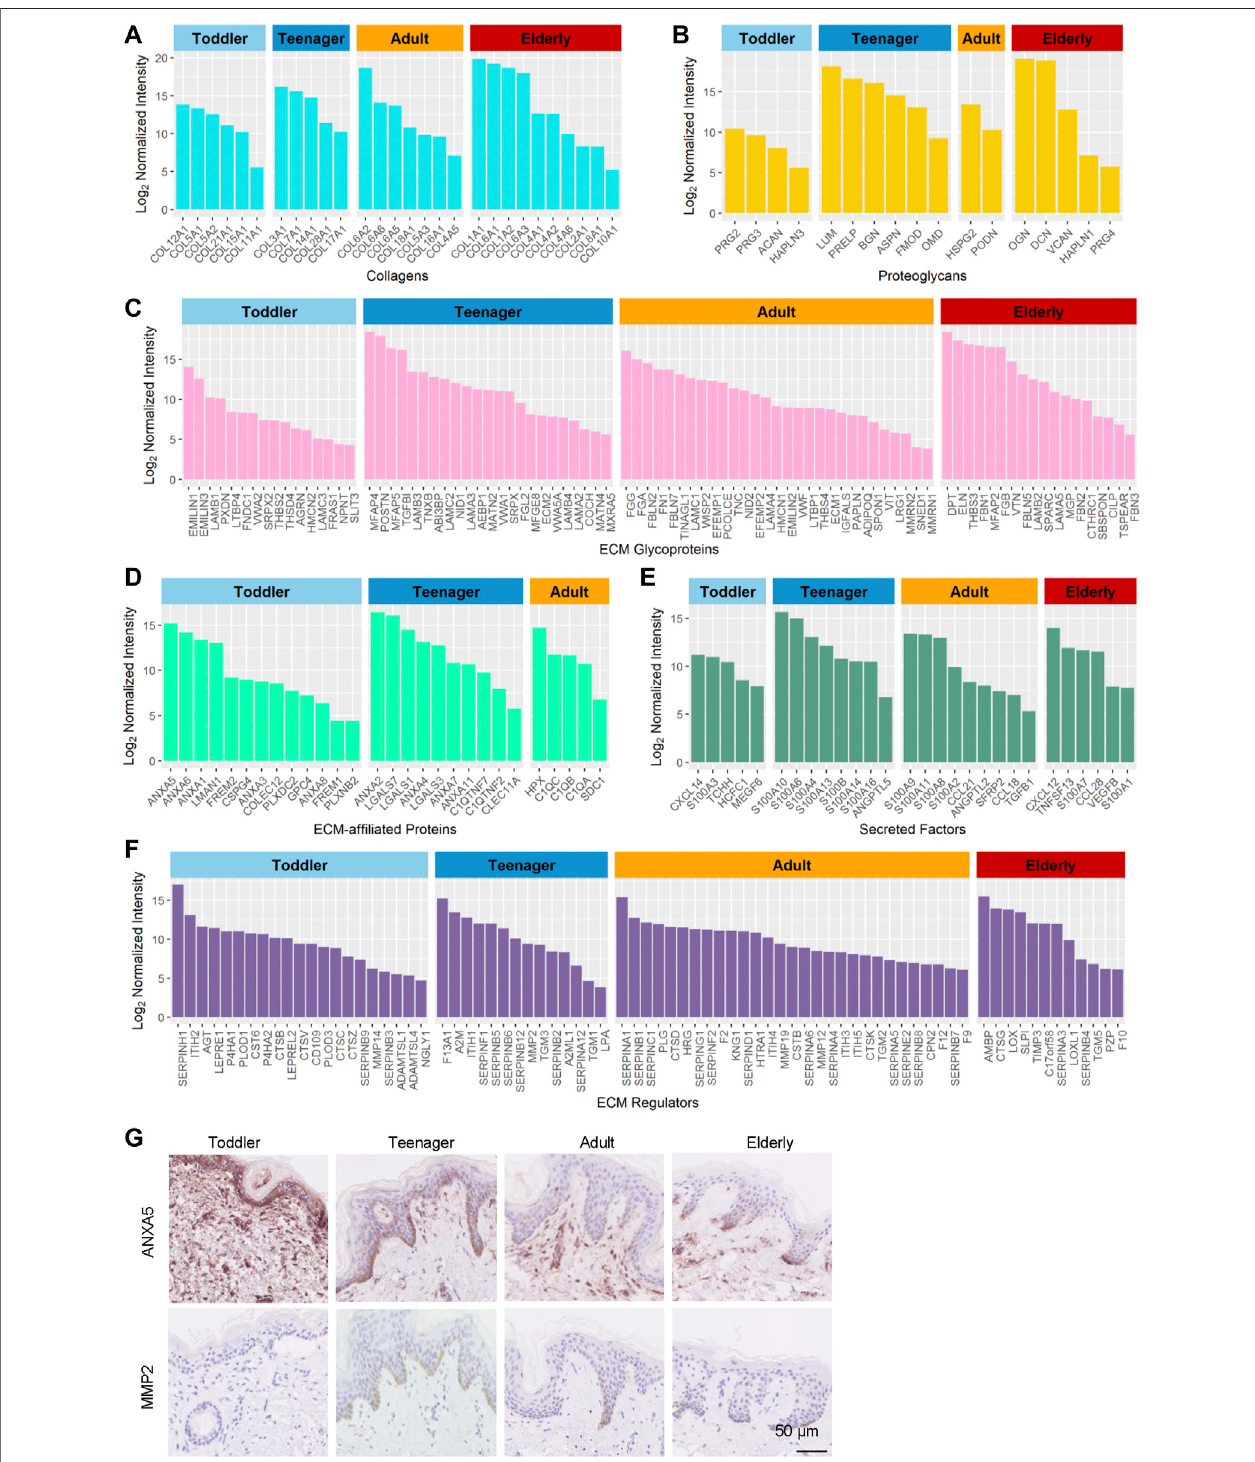
FIGURE 3 | Highly expressed proteins of the six ECM components in the human skin dermis at four ages (toddler, teenager, adult, and elderly). (A – F) Histograms show highly expressed proteins of the collagen ECM, proteoglycan ECM, ECM glycoprotein, ECM-af fi liated protein, secreted factor ECM, and ECM regulator, respectively. (G) Immunohistochemistry of ANXA5 and MMP2 in the skin tissues of toddler, teenager, adult, and elderly (scale bar represents 50 μ m).